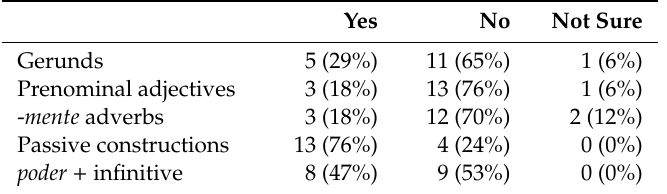
Table 5. Instructors’ responses to whether the features constitute anglicisms ( N = 85).